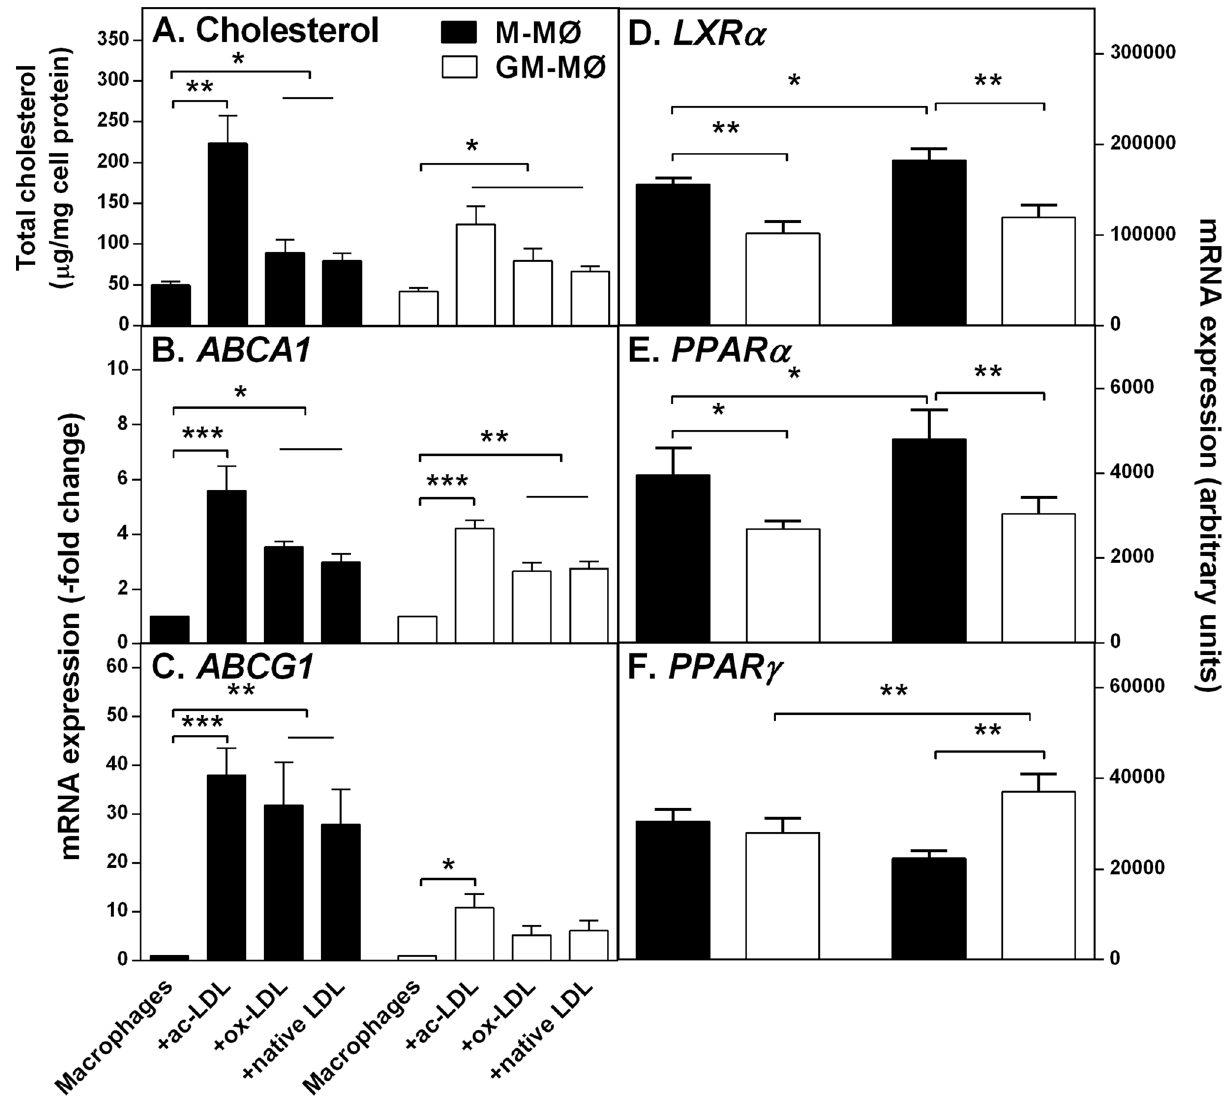
Figure 5. Effect of cholesterol loading on the gene expression of ABC transporters and related transcription factors in M-MØ and GM-MØ foam cells. M-MØ and GM-MØ were cholesterol-loaded for 24 h with 25 µg/ mL of acetyl-LDL (ac-LDL), oxidized-LDL (ox-LDL), or native LDL. ( A ) Cholesterol was quantified by HPTLC, and expression of ( B ) ABCA1 and ( C ) ABCG1 was determined by quantitative RT-PCR. Data in panels ( B ) and ( C ) indicate mRNA expression levels relative to those in the non-loaded cells (Macrophages) (set at 1). Gene expression of ( D ) LXRA , ( E ) PPARA , and ( F ) PPARG was determined in acetyl-LDL generated foam cells of each subtype. Data in panels ( D ) to ( F ) indicate mRNA values expressed as arbitrary units. *p < 0.05, **p < 0.01, and ***p < 0.001 by one-way ANOVA. Data are presented as means ± SEM of 4–9 individual blood donors and triplicate incubations for each loading condition and gene of